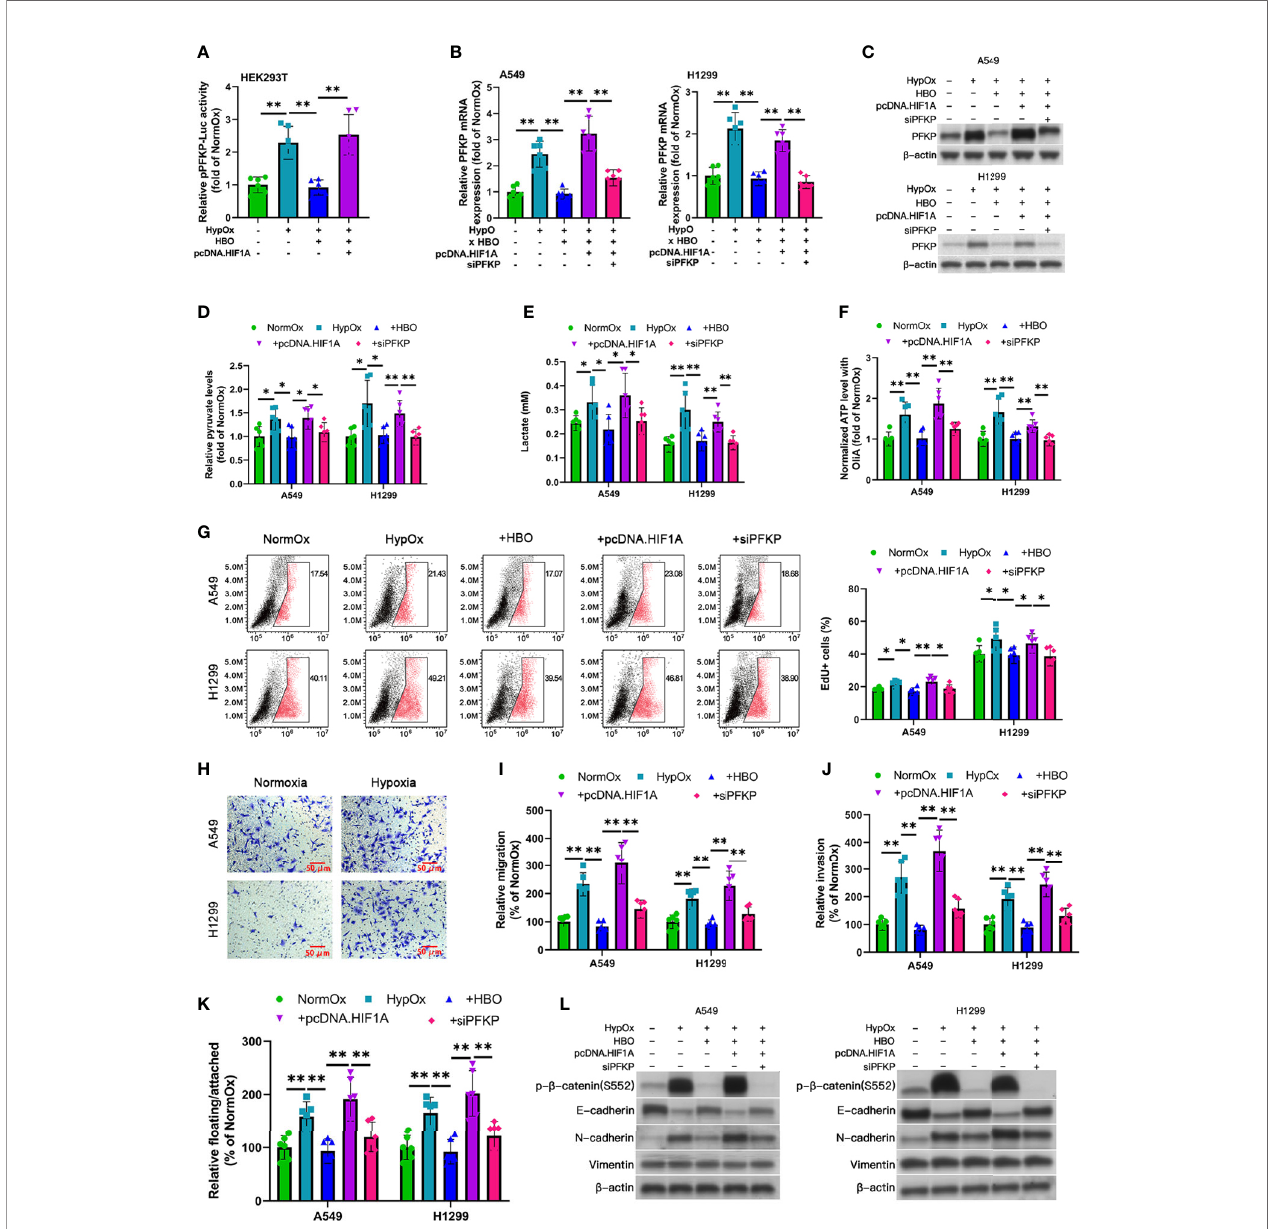
FIGURE 3 | Reduced Warburg effect, hyperproliferation, and EMT in HBO-treated hypoxic NSCLC cell lines mediated by HIF-1 a /PFKP axis. (A) PFKP-Luc reporter activity in HEK293T cells subjected to hypoxia (HypOx) with or without hyperbaric oxygen (HBO) and pcDNA.HIF1A. (B – L) A549 and H1299 NSCLC cells were subjected to hypoxia (HypOx) with or without hyperbaric oxygen (HBO) in the presence of pcDNA.HIF1A and siPFKP transfection. (B, C) Gene expression and protein levels of PFKP in A549 and H1299 cells. Peptidylprolyl isomerase A (PPIA) was used as the qPCR housekeeping gene. (D) Intracellular pyruvate levels in A549 and H1299 cells. (E) Lactate secretion in A549 and H1299 cells. (F) ATP levels in A549 and H1299 cells incubated with oligomycin A for 1 h. (G) EdU staining in A549 and H1299 cells. (H) Representative images of Transwell assays of cell migration. Scale bar = 50 m m. (I, J) Quanti fi cation of migration and invasiveness by Transwell assays in A549 and H1299 cells. (K) Quanti fi cation of detachment in A549 and H1299 cells. (L) Immunoblotting of p- b -catenin (S552), E-cadherin, N-cadherin, and vimentin in A549 and H1299 cells. Data represented as means ± SDs. n = three biological replicates × two technical replicates. * P < 0.05, ** P < 0.01 [one-way